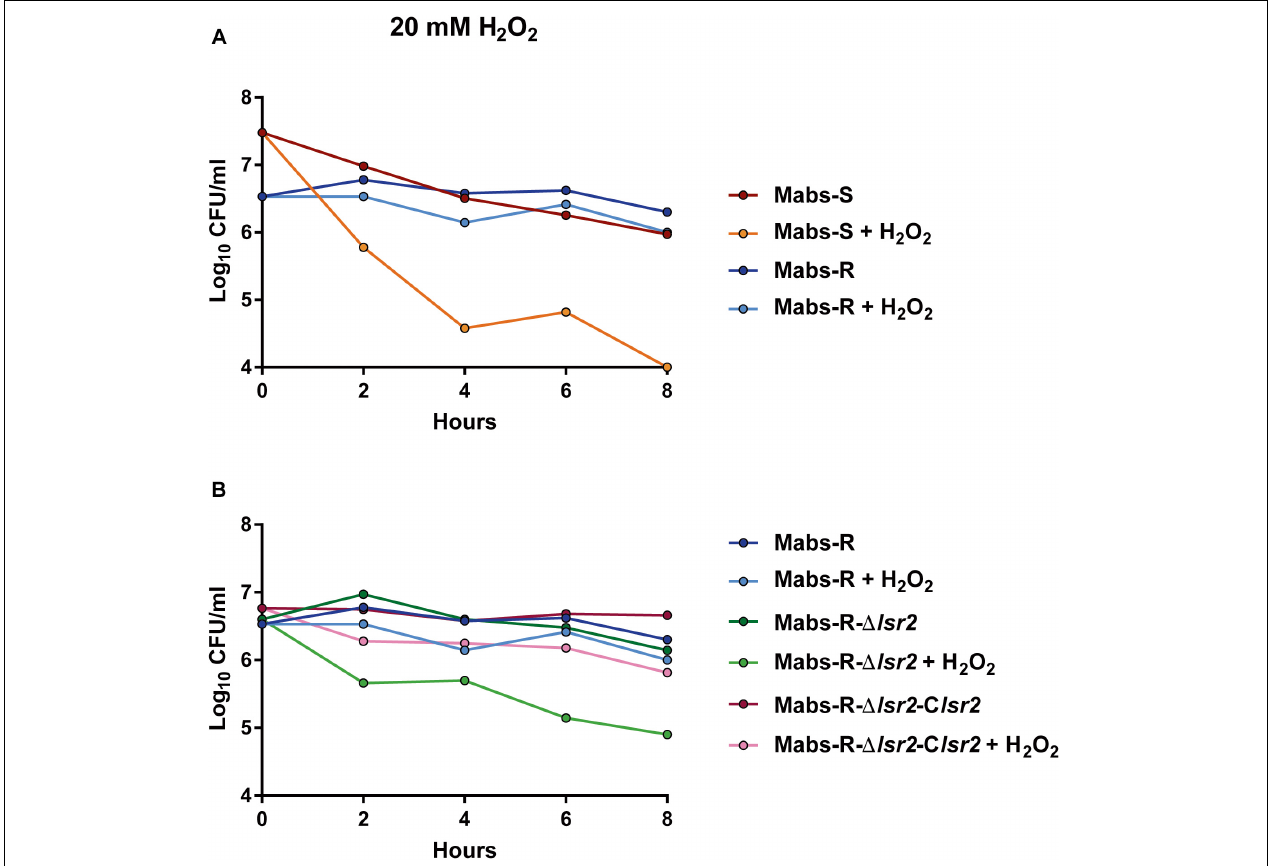
FIGURE 4 | Susceptibility profile of M. abscessus toward oxidative derivatives. Strains were grown in broth medium until exponential phase and exposed to 20 mM H 2 O 2 . Growth was monitored by CFU counting at 2, 4, 6, and 8 h. (A) Comparative response of M. abscessus S and R variants to the treatment. (B) Comparative response of Mabs-R- (cid:49) lsr2 , Mabs-R- (cid:49) lsr2 and Mabs-R (cid:49) lsr2 - Clsr2